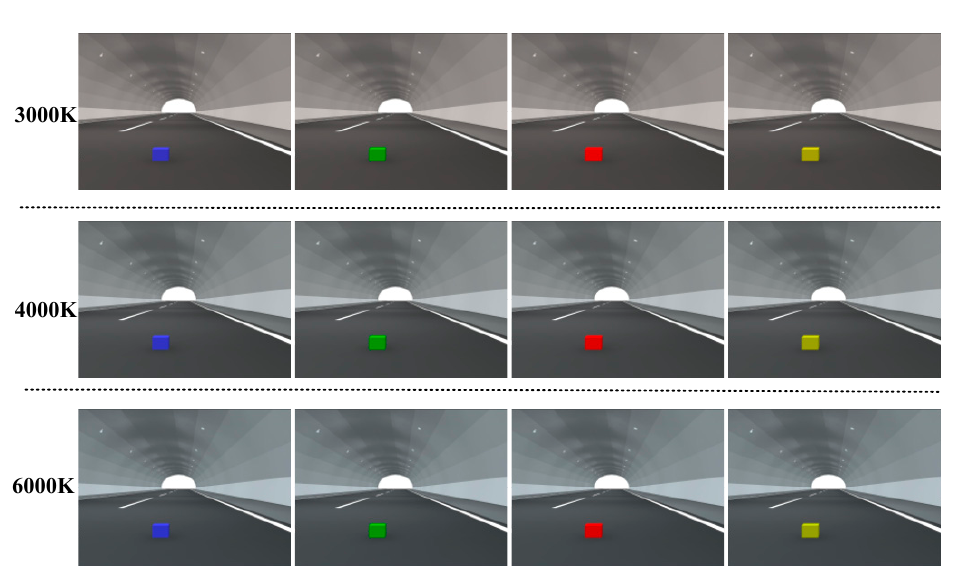
Figure 12. Different lighting environments.